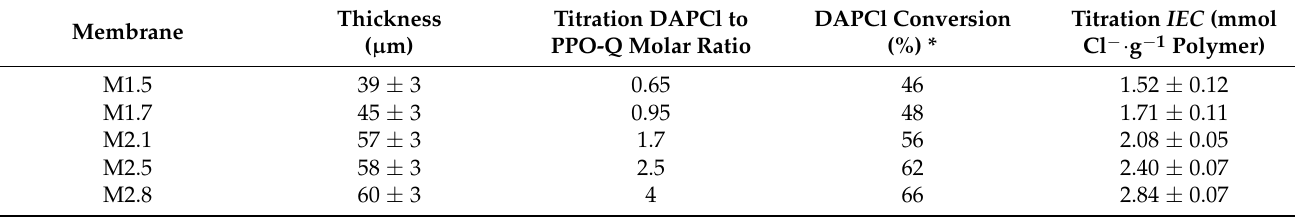
Table 2. Chemical composition and membrane properties of the five prepared AEMs. Thickness Titration DAPCl to Membrane ( µ m) PPO-Q Molar